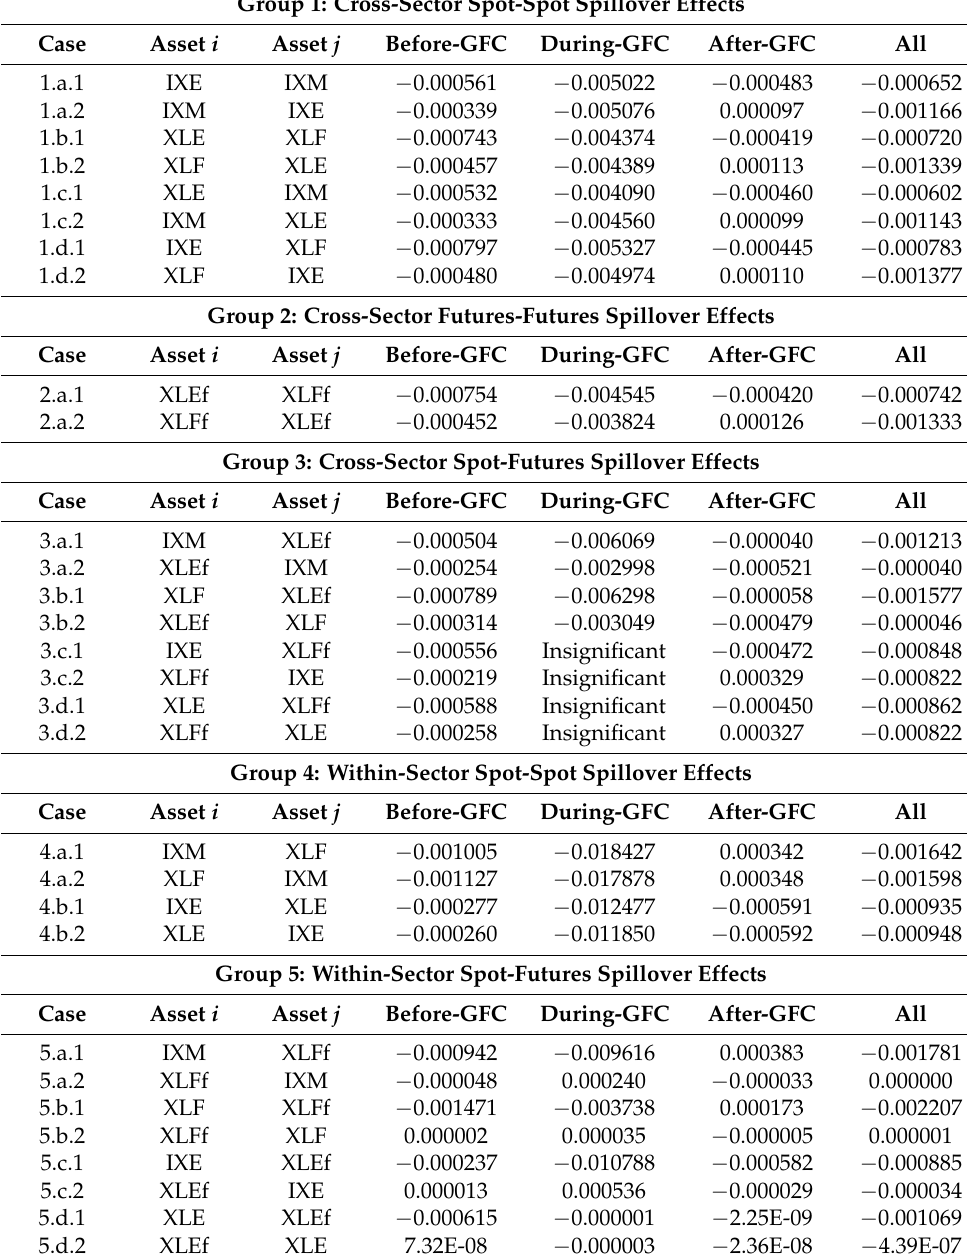
Table 6. Mean co-volatility